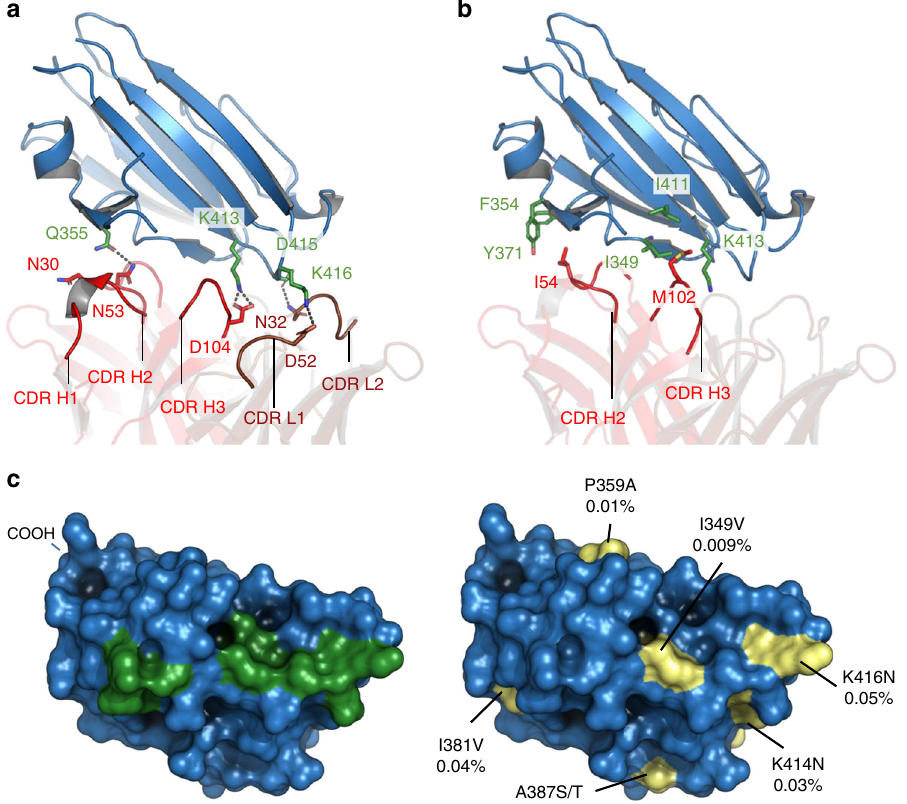
Fig. 5 Determinants and conservation of the epitope targeted by 85RF45.1. a , b Direct interactions between the CDR loops of 85RF45.1 and charged residues ( a ) or hydrophobic patches ( b ) in Pfs48/45-6C. Heavy and light chain CDRs are coloured as in Fig. 4. Residues that directly interact are shown as stick representation (green for Pfs4845 residues, red and dark red for 85RF45.1 residues). Hydrogen bonds are indicated by dashed grey lines. c Surface footprint of 85RF45.1 on Pfs48/45-6C, represented by directly interacting residues, coloured in green. Residues that vary among >2400 Pfs48/ 45 sequences are shown in yellow and the observed substitutions as well as the overall frequency of substitutions are